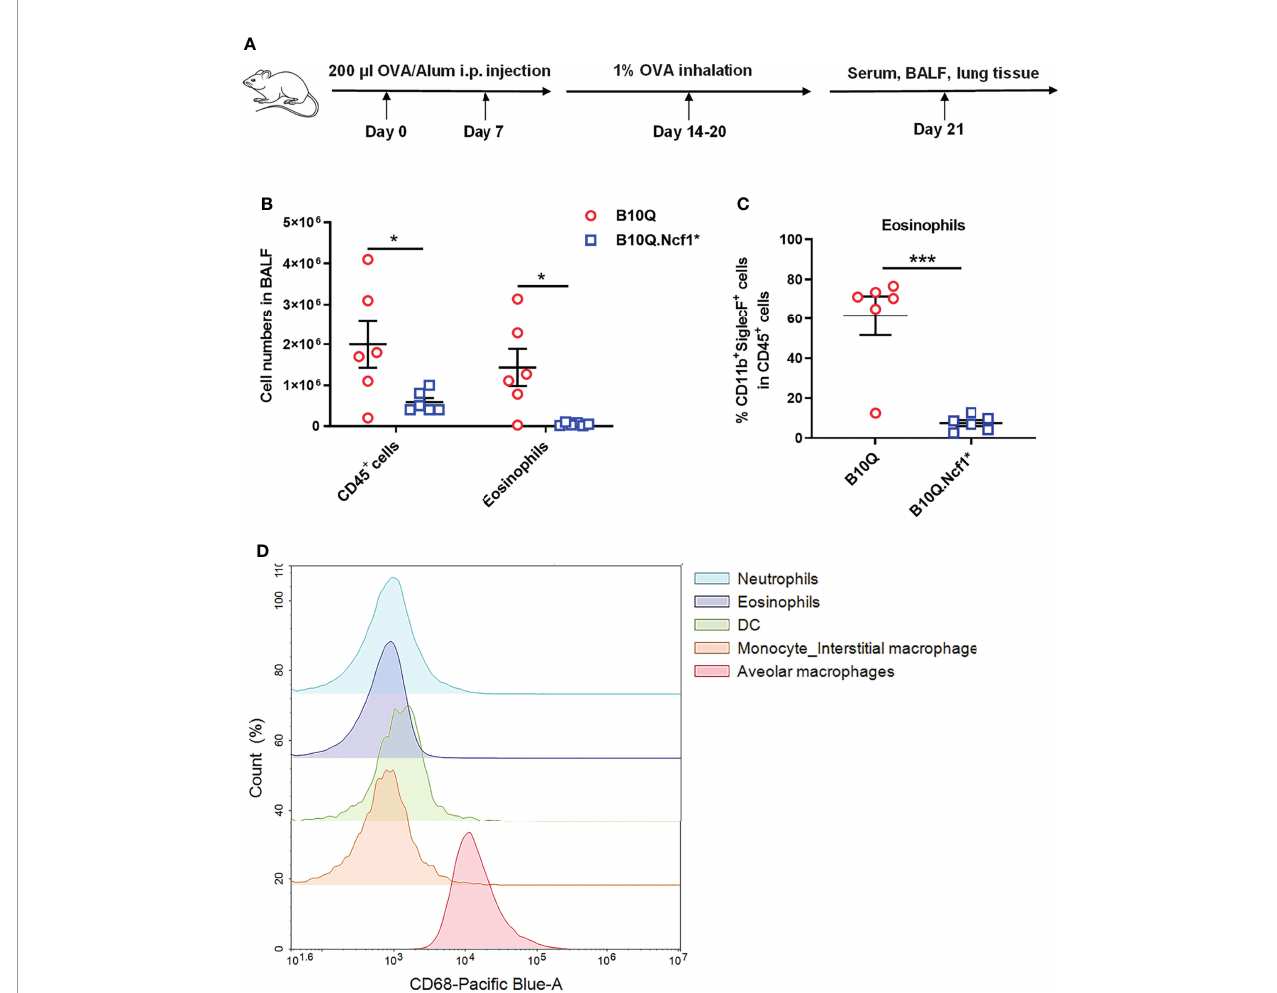
FIGURE 1 | Systemic de fi ciency of Ncf1 alleviates lung in fl ammation in mice. (A) A scheme of antigen-induced pulmonary in fl ammation model in mice. B10Q and B10Q. Ncf1 * mice were induced to develop AIPI (n = 6 per group). (B, C) The number of CD45 + cells and eosinophils in BALF were analyzed by fl ow cytometry, and the proportion of eosinophils in CD45 + cells was determined. (D) The CD68 + cells in BALF were also identi fi ed by fl ow cytometry. All values are expressed as means ± SEM. * P < 0.05 and *** P < 0.001, using student ’ s t